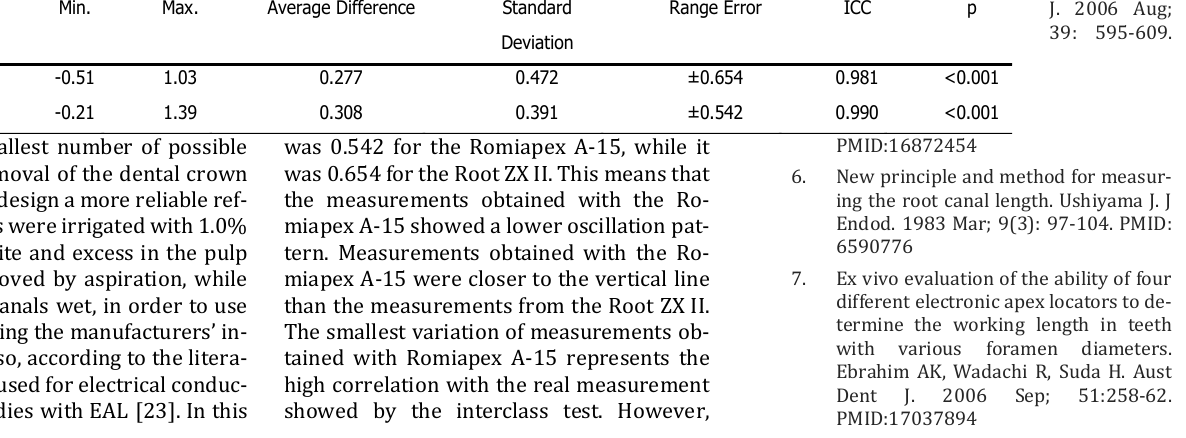
ments of root canals.